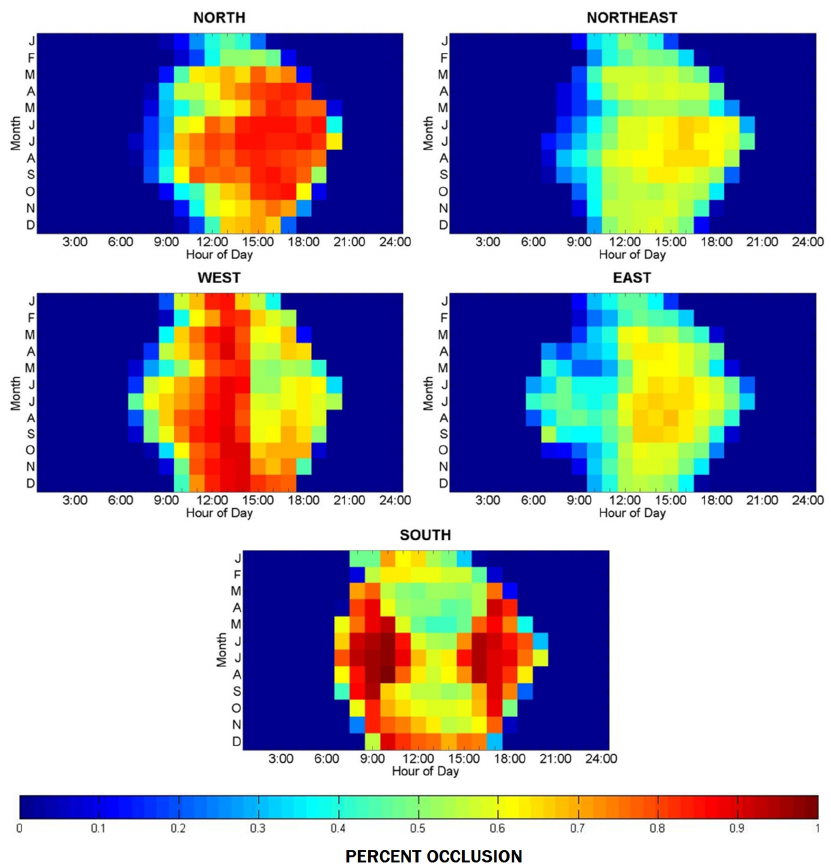
Figure 19. Hourly average percent occlusion for second floor (DGI 20